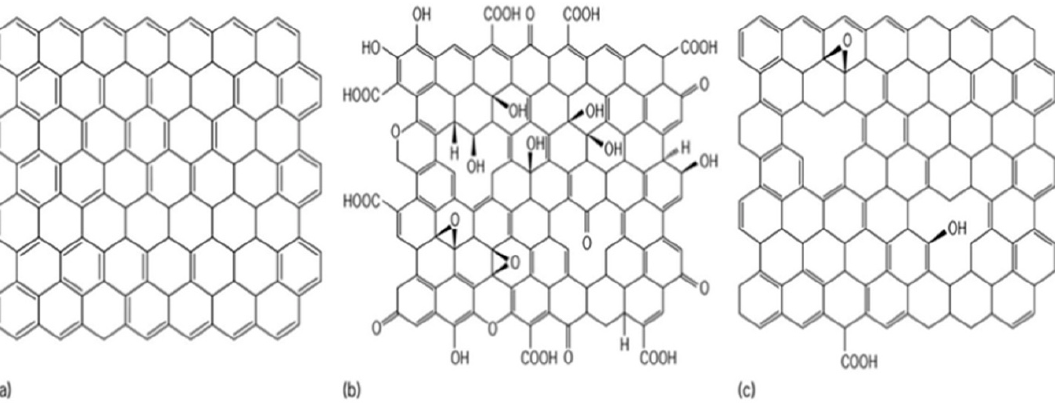
Figure 4. Chrystal structures of ( a ) graphene, ( b ) graphene oxide, and ( c ) reduced graphene oxide [133]. Copyright: Elsevier (2020).